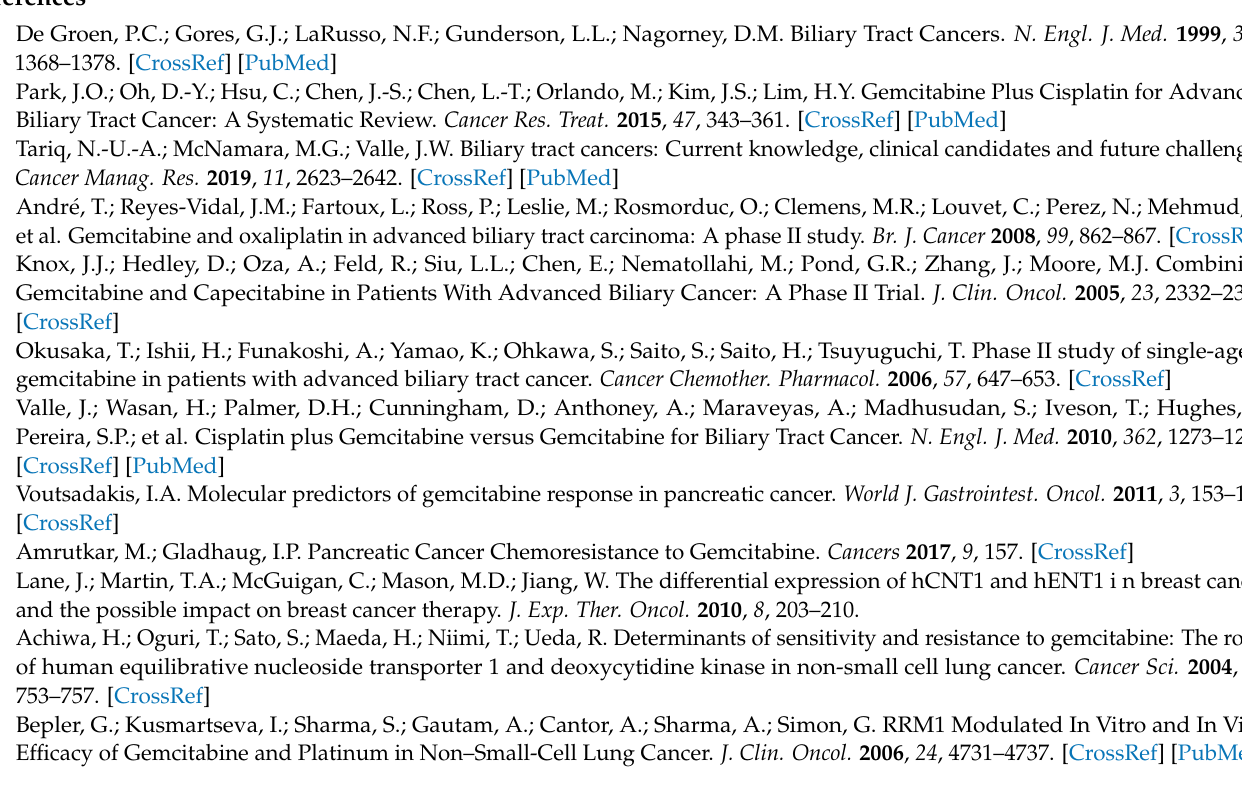
Table S3: Multivariate analysis for overall survival in each biomarker including peritoneal seeding or number of metastatic